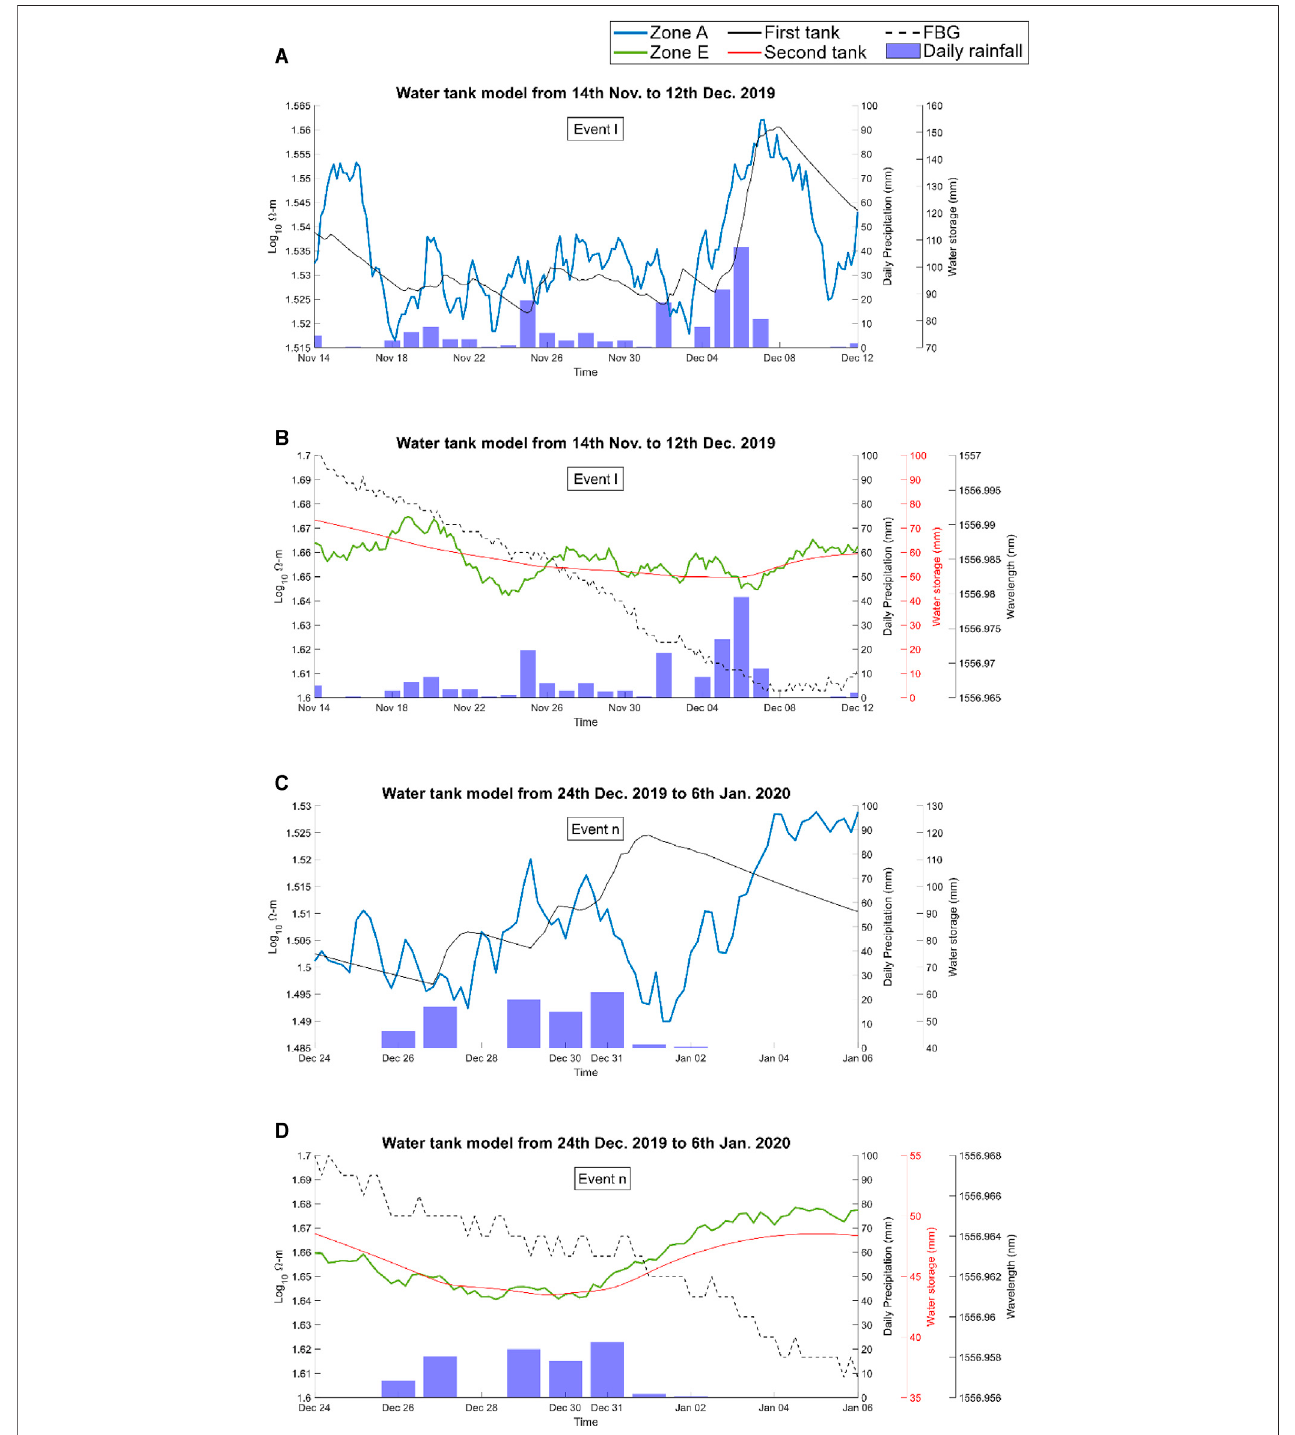
FIGURE 12 | Comparison of the Z-score of the MEER time series, water tank model, and fi ber Bragg grating sensor array (FBG) for the long-duration (Event l) and short-duration(Event n )precipitationevents.Themovingaveragefor20measurementsoftheMEERcurves.Eventl: (A) ZoneAand fi rsttankmodel; (B) ZoneE,second tank model, and the FBG. Event n : (C) Zone A and fi rst tank; (D) Zone E, second tank model, and the FBG. Note that the shallower Zone A could be correlated with the shallower, fi rst tank whereas the deeper Zone E with the deeper, second tank. The discrepancy between the MEER and the fi rst curves in (c) for the short-duration Event n may imply the complexity of geological material in response to the magnitude of rainfall in fi ltration.